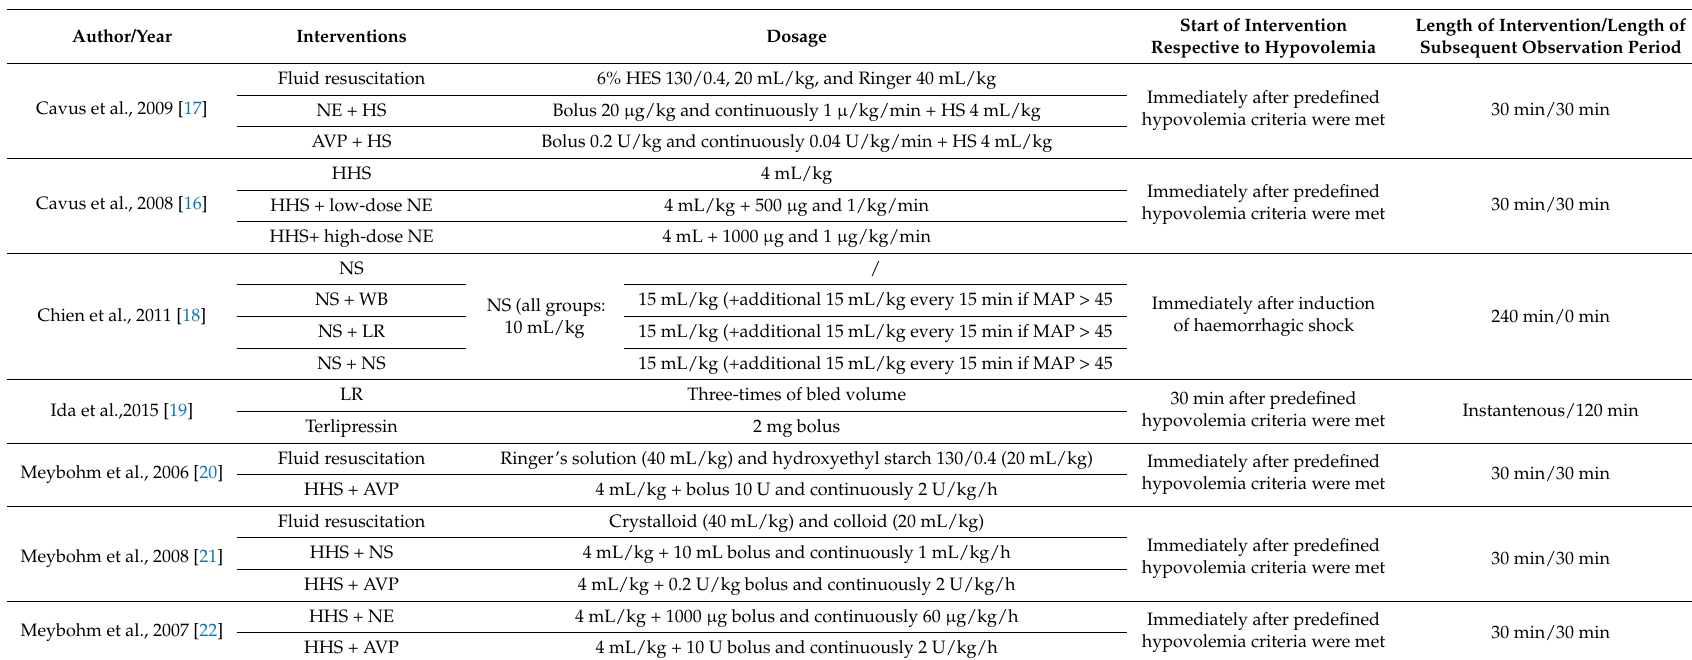
Table 3. Neuroprotective interventions with HHS or vasopressin or